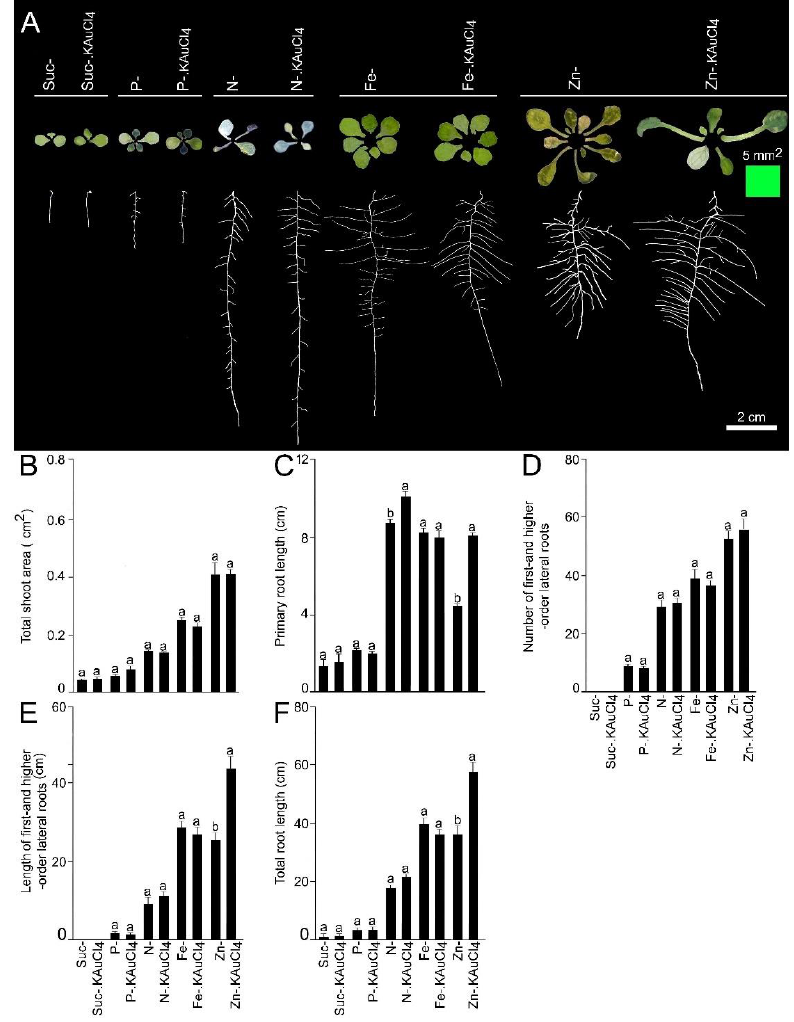
Figure 4. The deficiency of Suc and different essential nutrient elements affected KAuCl 4 -mediated augmented developmental responses of the shoots and roots. Wild-type Arabidopsis seedlings were initially grown hydroponically in NR medium for 7 d and then transferred to an NR medium deprived of Suc (Suc-), Pi (P-), N (N-), Fe (Fe-), and Zn (Zn-), and these media were supplemented with 10 ppm KAuCl 4 (Suc-.KAuCl 4 , P-.KAuCl 4 , N-.KAuCl 4 , Fe-.KAuCl 4 , and Zn-.KAuCl 4 ) for further 7 d. ( A ) The seedlings were removed from the hydroponic system, shoots and roots separated, and spread on an agar plate (1.0%; w / v ) to document their phenotypes. ( B – F ) Data are presented for ( B ) total shoot area, ( C ) primary root length, ( D ) the number of first- and higher-order lateral roots, ( E ) total length of first- and higher-order lateral roots, and ( F ) total root length. Values ( B – F ) are means ± SE ( n = 12), and different letters on the histograms indicate significant differences ( p <